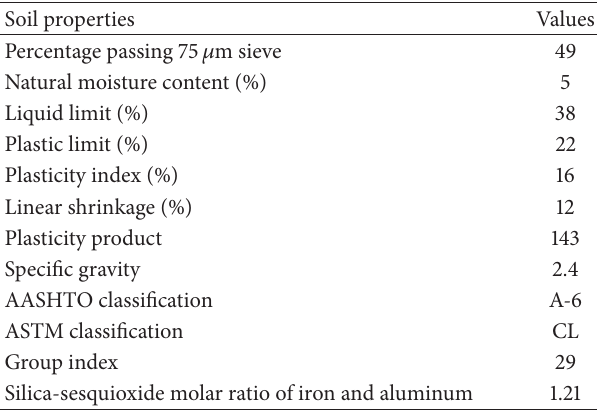
Table 1: Particle size analysis results of the laterite. Table 2: Physical properties of the laterite.